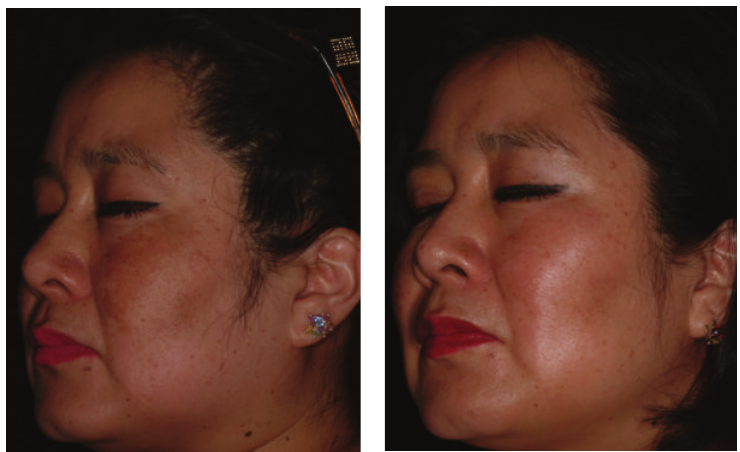
Figure 2: Left side treated with HQ: Onset and 8 weeks later with an excellent